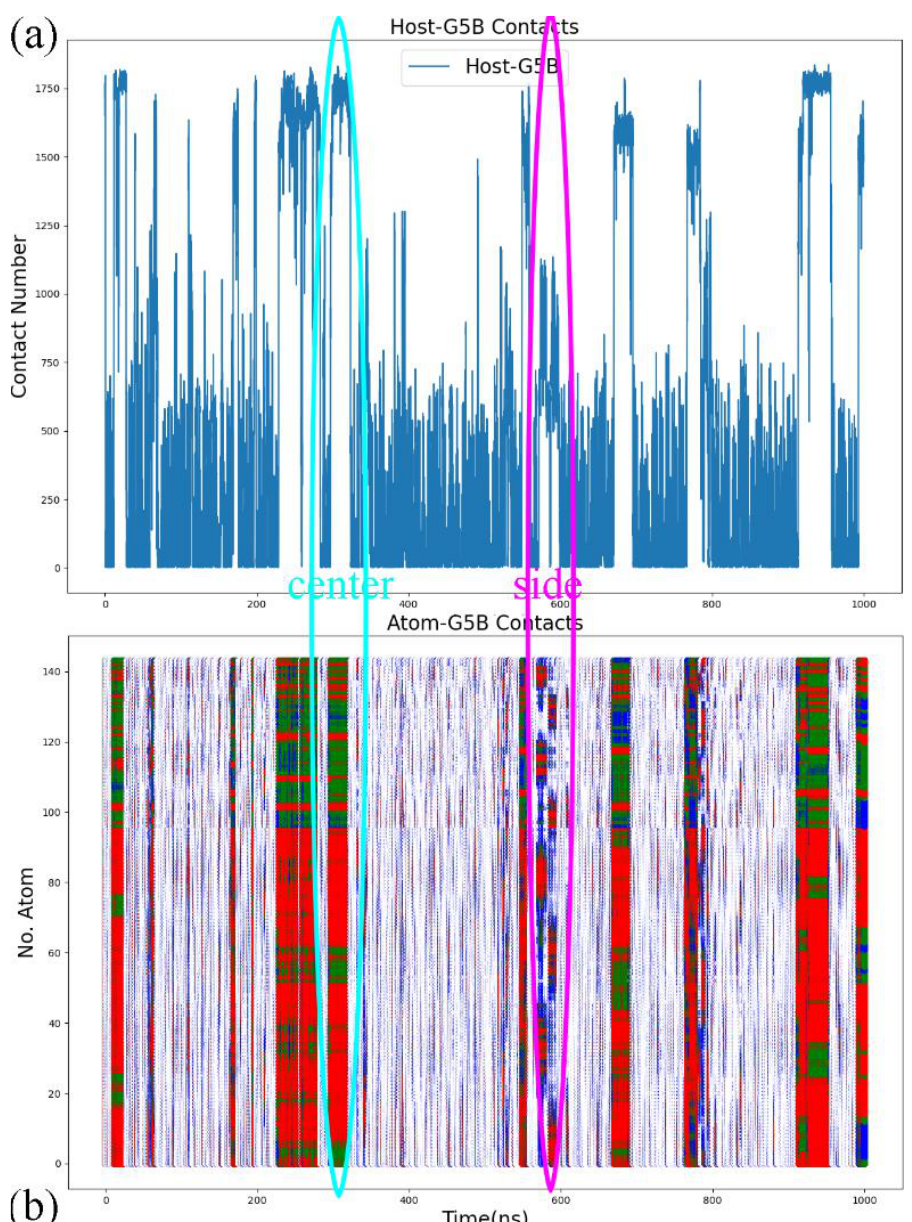
Figure 5. ( a ) The number of contacts between all atoms of the host CB8 and the guest deprotonated G5 and ( b ) its decomposition by each atom of the host during 1000 ns enhanced sampling simulations with the newly refitted FM-PM6 parameters. The y-axis represents the serial number of host atoms. The first 96 atoms of the host are heavy atoms, and the others are hydrogen atoms. Red dots denote contacts larger than 10, green dots represent contact numbers between 5 and 10, blue ones are those larger than 1, and the other are represented by white dots. The cyan oval provides an example of the typical center-binding pose explored during enhanced sampling simulations, while in the magenta one there is a side-binding mode.